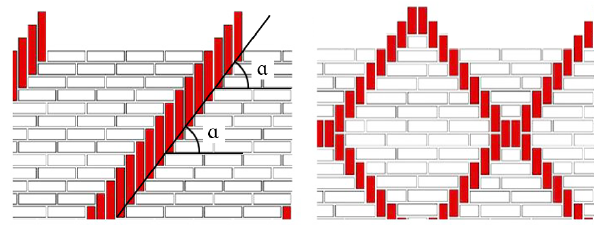
Figure 1: Right: herringbone pattern. Left: crossed-herringbone